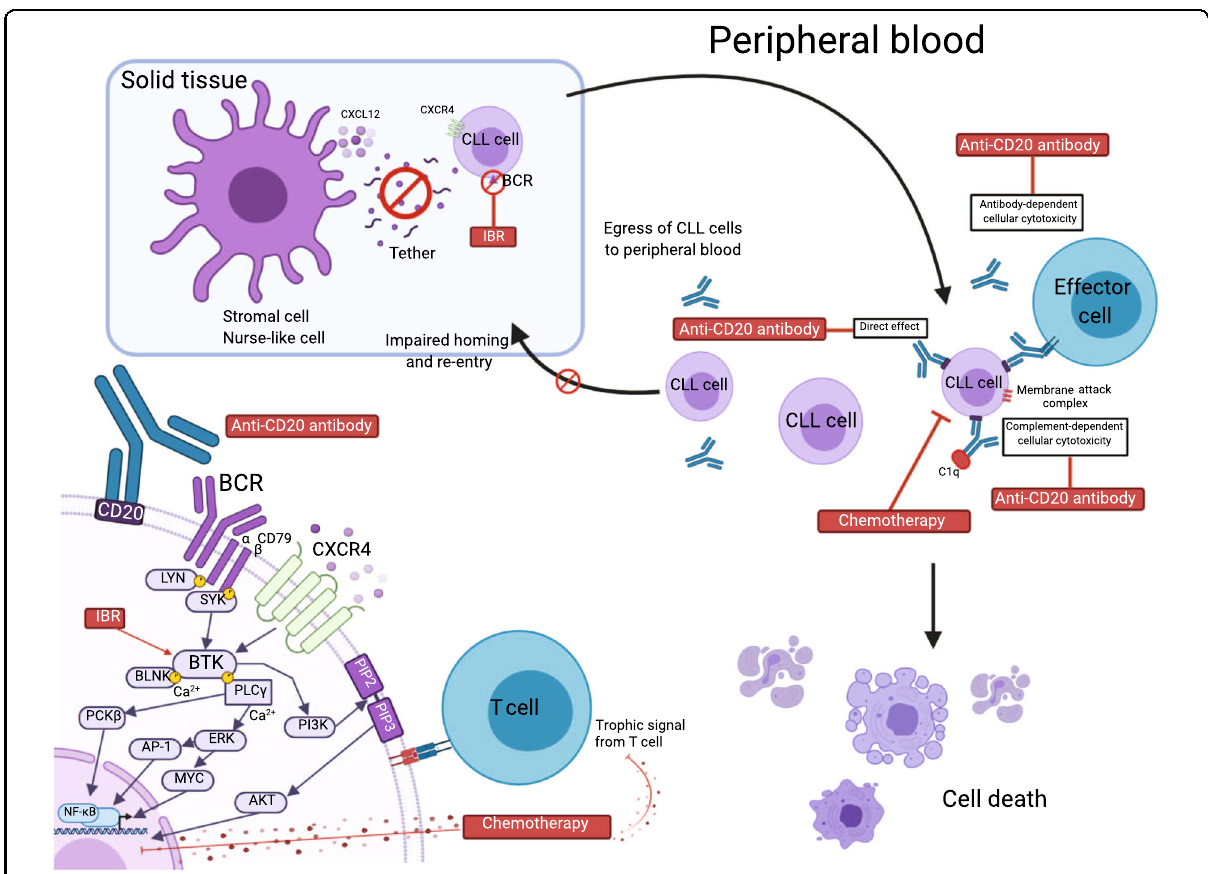
Fig. 2 Rationale for ibrutinib combination with chemoimmunotherapy. Ibrutinib (IBR) leads to CLL cell mobilization from the nodal compartment, making CLL cells more accessible to chemotherapy and anti-CD20 antibody in peripheral blood. Lower left diagram depicts intracellular mechanism of combination. Anti-CD20 antibody along with chemotherapy induces apoptosis and immunologic cell death, while ibrutinib affects proliferation, survival, and migration of B cells. Chemotherapeutic agents such as fl udarabine are well known to cause depletion of all T cell subsets, thereby reducing negative trophic signals between T cells and CLL cells. This fi gure was created with BioRender.com. BCR, B cell